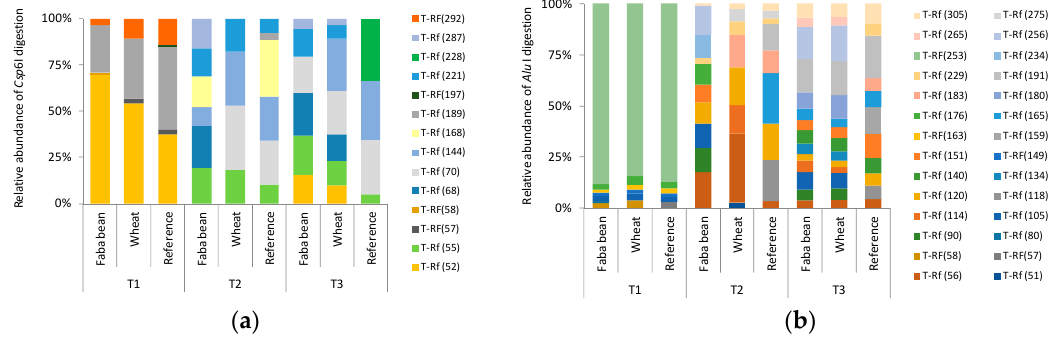
Figure 2. Abundance of terminal restriction fragment gel polymorphism (t-RFLP) fragments of ammonia-oxidizing archaea (AOA) in soil after digestion by Csp 6I ( a ) and Alu I ( b ). T1, T2, and T3 denote: two months after residue incorporation into the soil, stem elongation, and the senescence stage of the subsequent wheat crop, respectively.